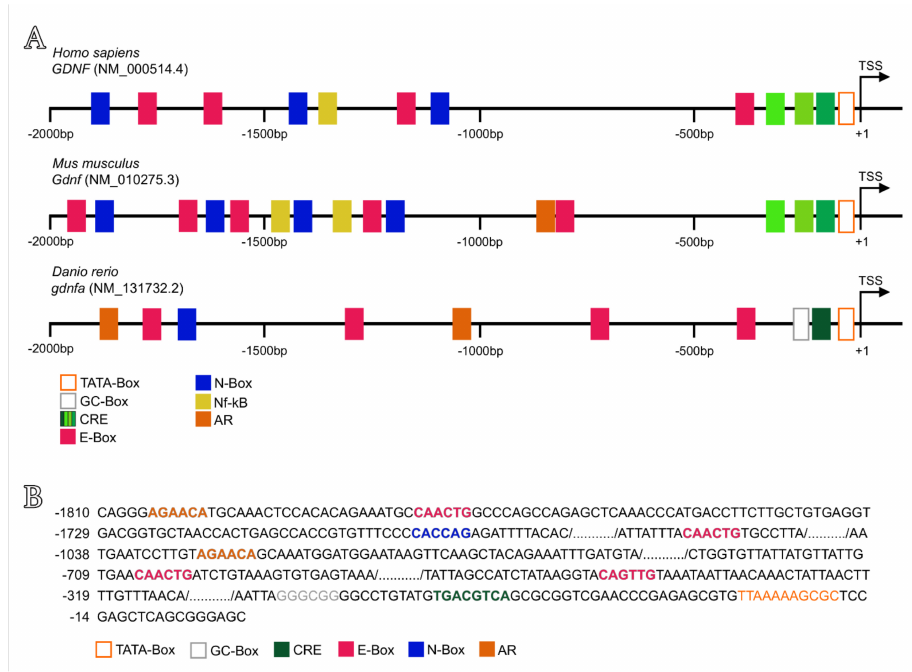
Figure 9. Predicted regulatory sequences upstream of human GDNF , mouse Gdnf and zebrafish gdnfa . ( A ) The upstream region (2000 bp) of human GDNF contains three different sequences of cAMP response elements (CRE), four E-box sequences, three N-box sequences and one Nf-kB binding site. The upstream region (2000 bp) of mouse Gdnf contains an N-box/E-box-rich region at bp − 1300 to − 1900 and additional E-boxes downstream, one androgen receptor binding site (AR), two Nf-kB binding sites and three different sequences of CRE close to the TSS (transcriptional start site). The upstream region (2000 bp) of zebrafish gdnfa contains four E-box sequences and one N-box sequence, two AR half sequences and only one CRE close to a GC-box and the TSS. TSS is the transcription start site (position +1). ( B ) Sequences of putative binding sites upstream of zebrafish gdnfa . In the open orange box is shown the TATA-box sequence, in the open gray box the GC-box, in the dark green box the CRE, in the pink box the E-box, in the blue box the N-box, and in the filled orange box the AR half binding